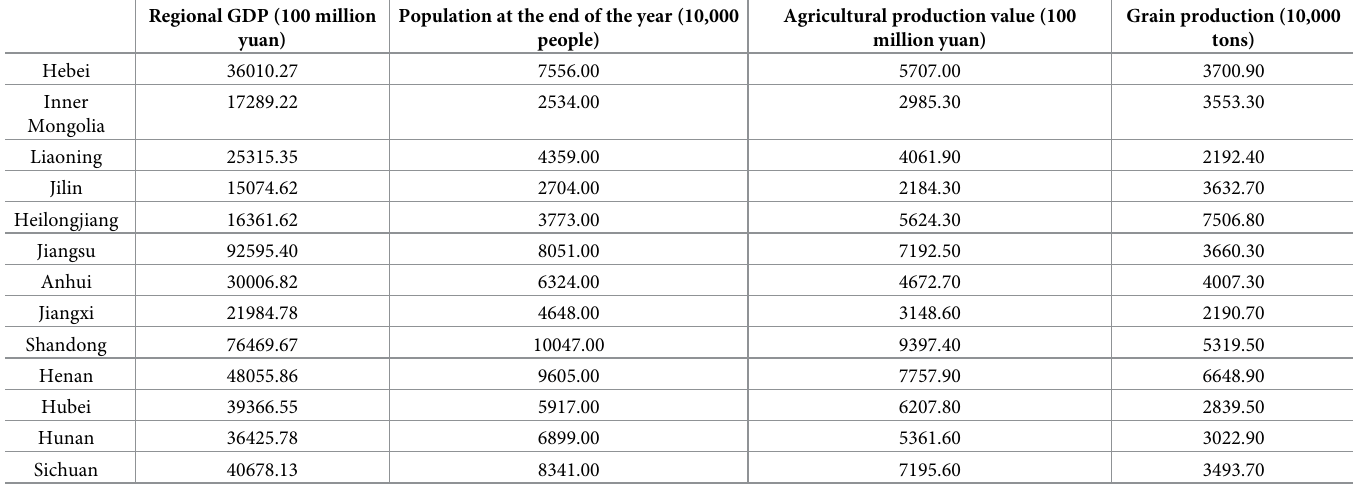
Table 1. Basic economic and social conditions in China’s main grain producing